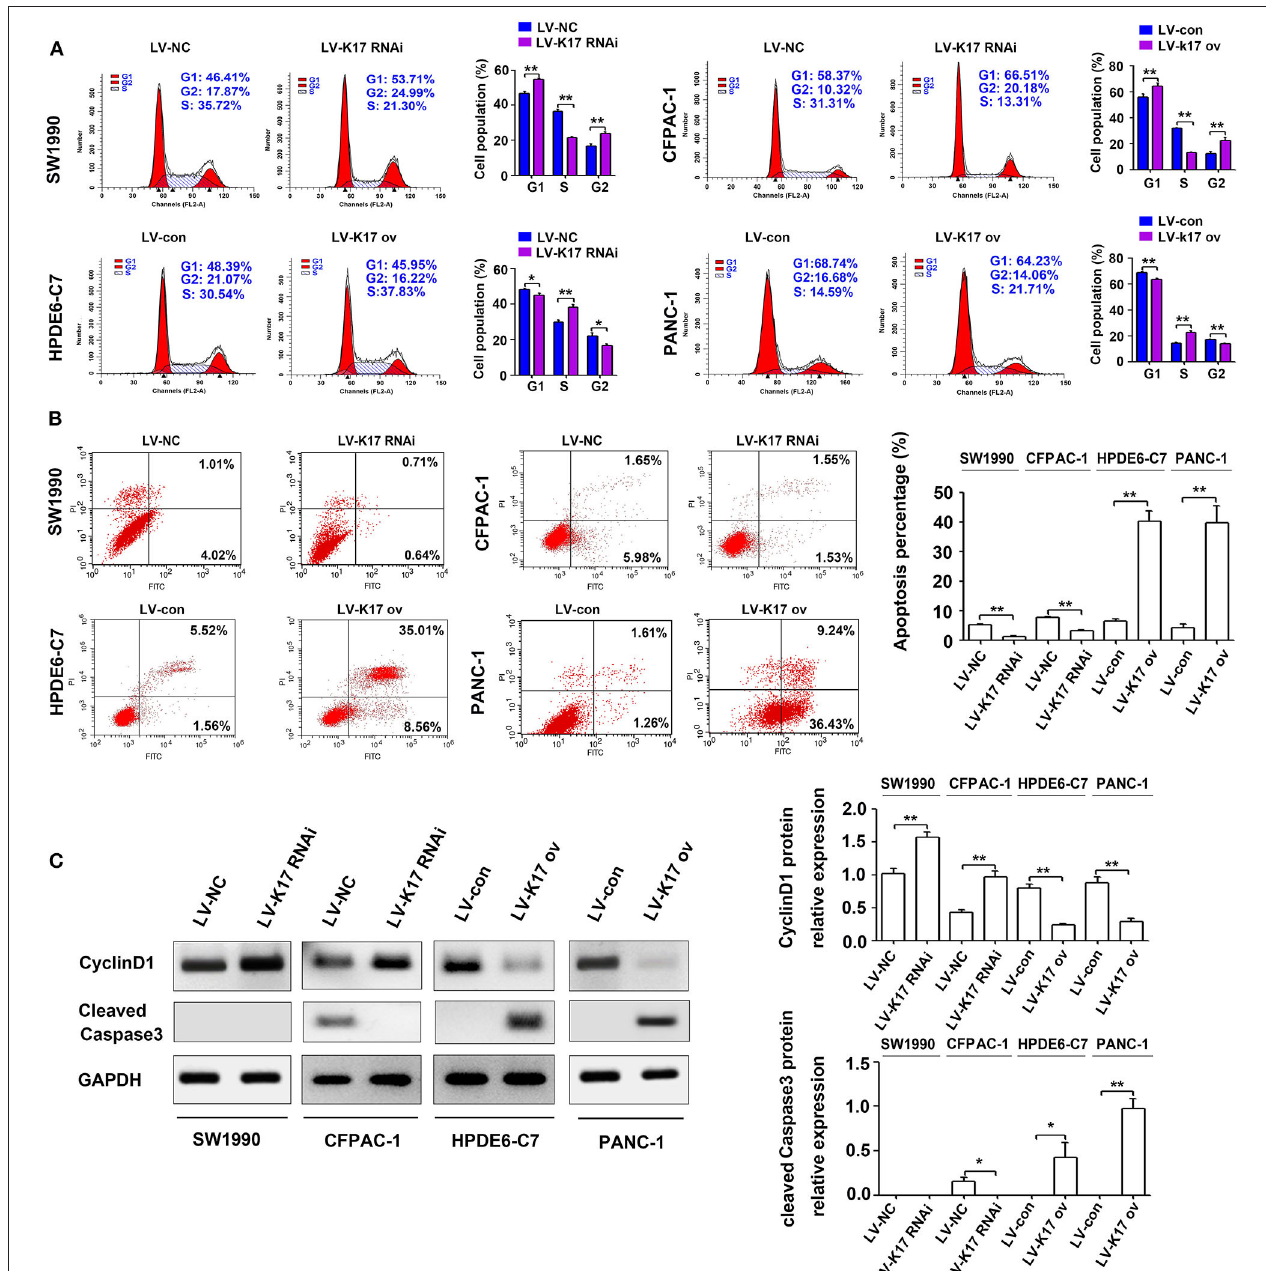
FIGURE 5 | K17 induced cell cycle arrest and cell apoptosis in pancreatic cancer cells in vitro . (A) Cell cycle distribution was analyzed by flow cytometry in stable K17 silenced SW1990 and CFPAC-1 cells and stable K17 upregulated HPDE6-C7 and PANC-1 cells. (B) Flow cytometry was used to determine the percentage of apoptotic cells in stable K17-silenced SW1990 and CFPAC-1 cells and in stable K17 upregulated HPDE6-C7 and PANC-1 cells. (C) Western blot analysis was performed to determine the expression of CyclinD1 and cleaved Caspase3 protein in stable K17-silenced SW1990 and CFPAC-1 cells and in stable K17 upregulated HPDE6-C7 and PANC-1 cells. * P < 0.05, and ** P <